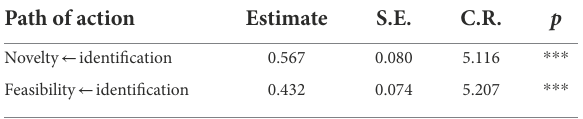
TABLE 4 Path coefficient and significance level between identification and creativity of family business.